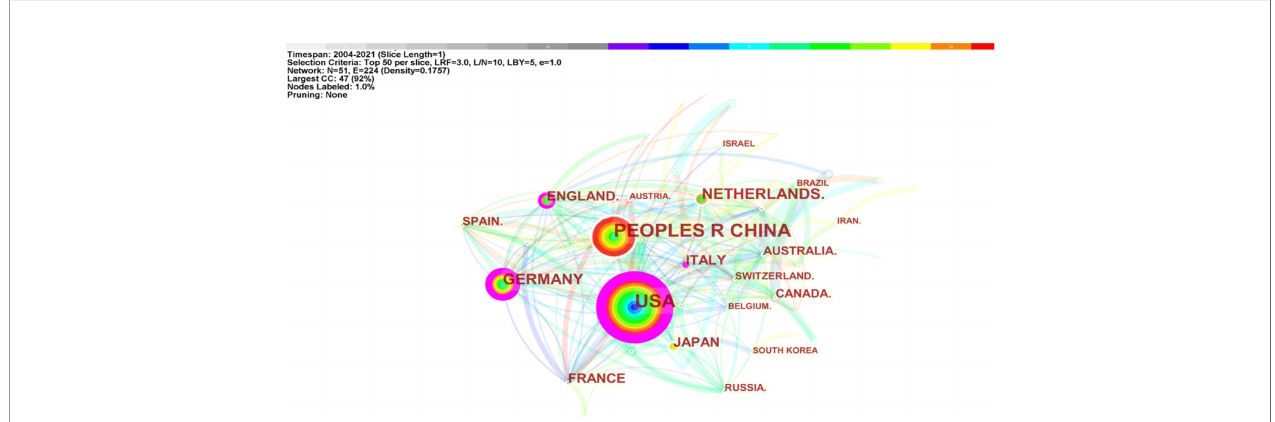
FIGURE 4 | Country co-occurrence map of macrophage polarization in AS research (T ≥